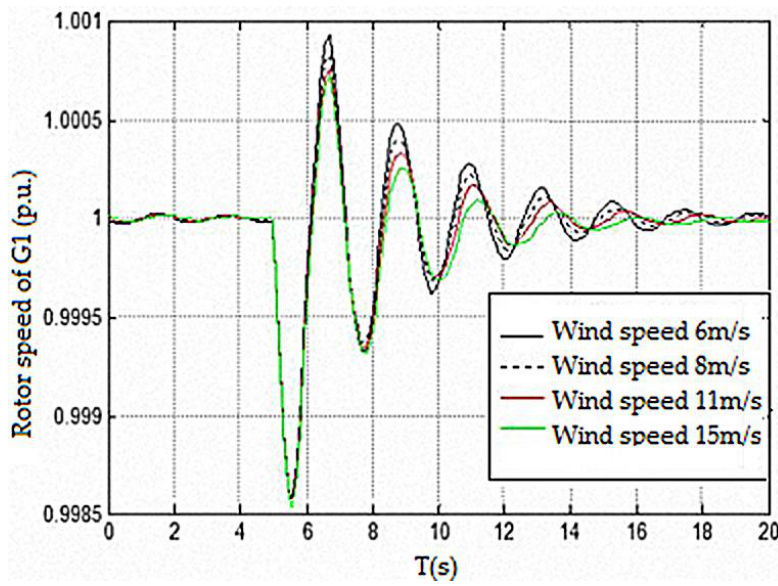
Figure 10. Rotor speed of G1 under different wind speed adopting novel damping control.